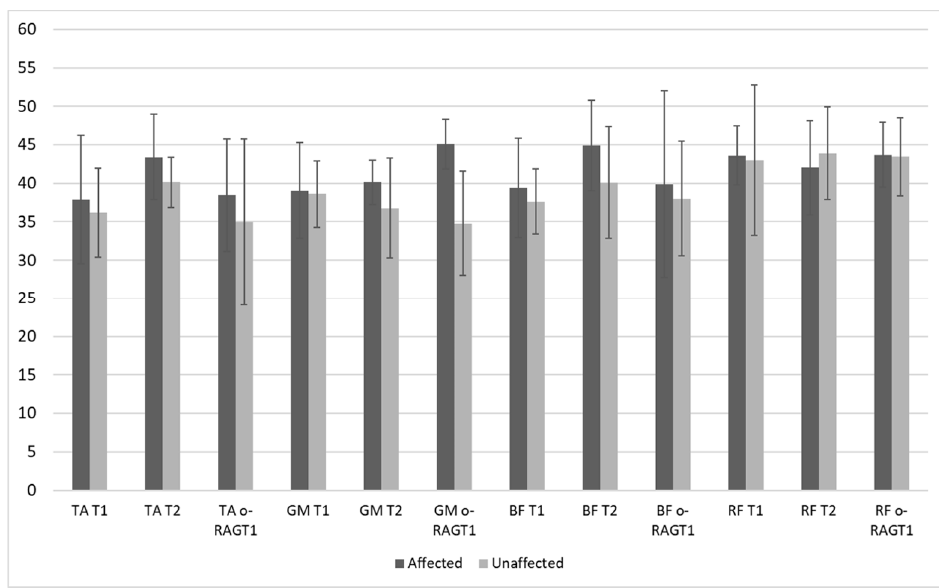
Figure 2. Root mean square (RMS) coefficient (mean values and standard deviations) at T1 and T2 during 10MWT ( N = 8), and during the first session of o-RAGT, o-RAGT 1 ( N = 5).